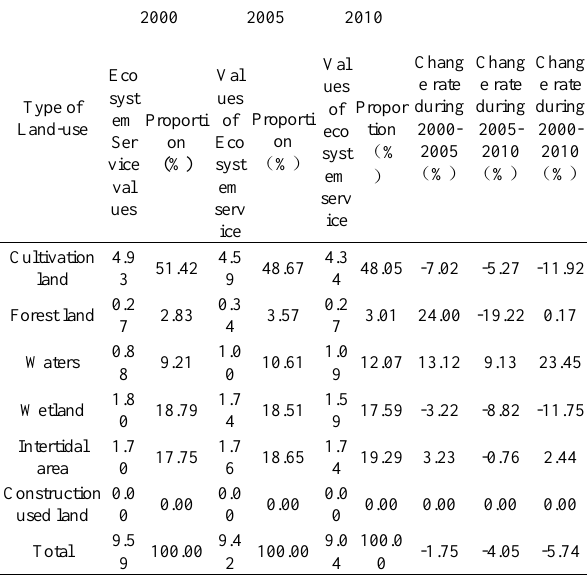
Table 2 Ecosystem services value and its proportion at 2000, 2005 and 2010 year in the study area Unit: 100 million yuan /